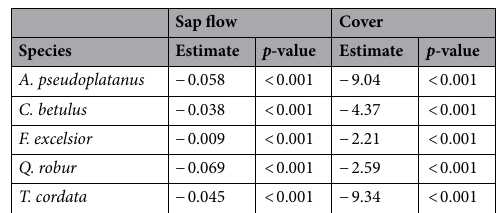
Table 1. Model results when testing for the change in mean centered sap flow density (JS) and canopy cover (%) for dry conditions being compared to moist conditions.